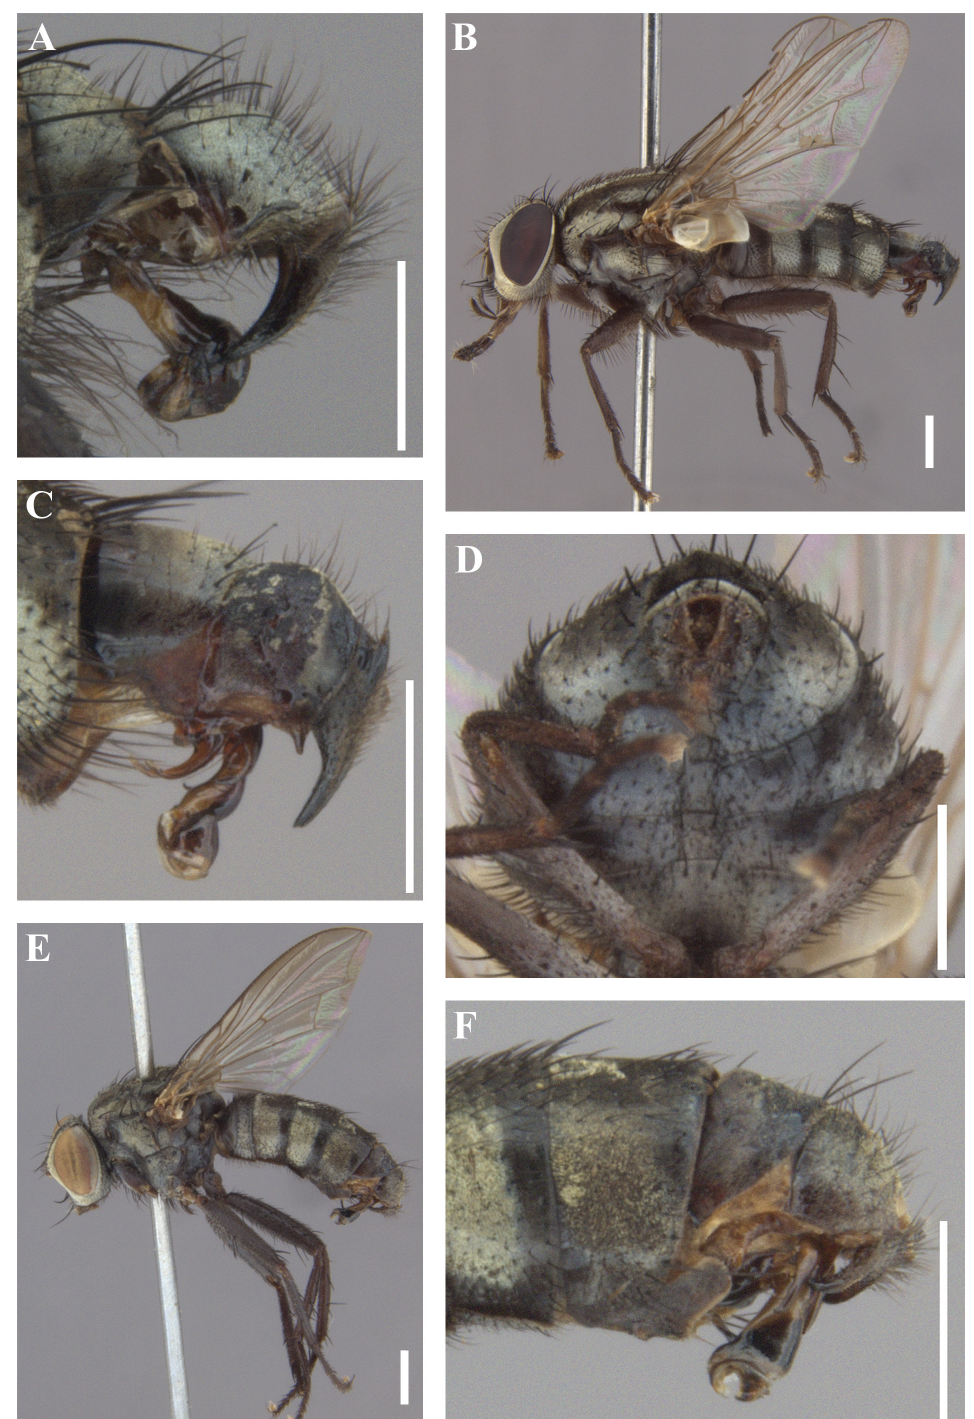
Fig. 8. Dexosarcophaga spp., ♂ and ♀, habitus and terminalia. A . Dexosarcophaga petra sp. nov., ♂, paratype (MNRJ [lost]), Brazil, Mato Grosso, Chapada dos Guimarães, terminalia, lateral view. B–D . Dexosarcophaga sphaera sp. nov., paratypes (MNRJ [lost]), Brazil, Brasília, Distrito Federal, Fazenda Vargem Bonita. B . ♂, habitus, lateral view. C . ♂, terminalia, lateral view. D . ♀, terminalia, ventral view. E–F . Dexosarcophaga napo sp. nov., ♂, paratype (NHRS [lost]), Ecuador, Napo Prov. E . Habitus, lateral view. F . Terminalia, lateral view. Scale bars = 1.0